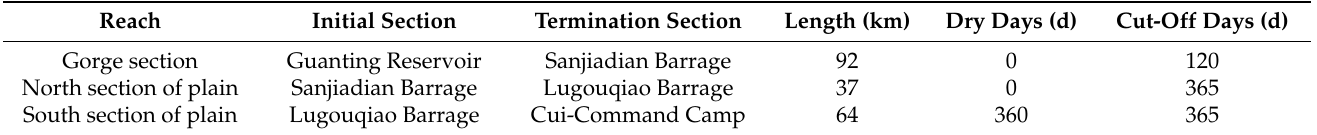
Figure 3. Change process of water resources of Yongding River from 1962 to 2018. Table 1. Average drying up statistics for the Yongding River (Beijing section) from 2005 to 2014.